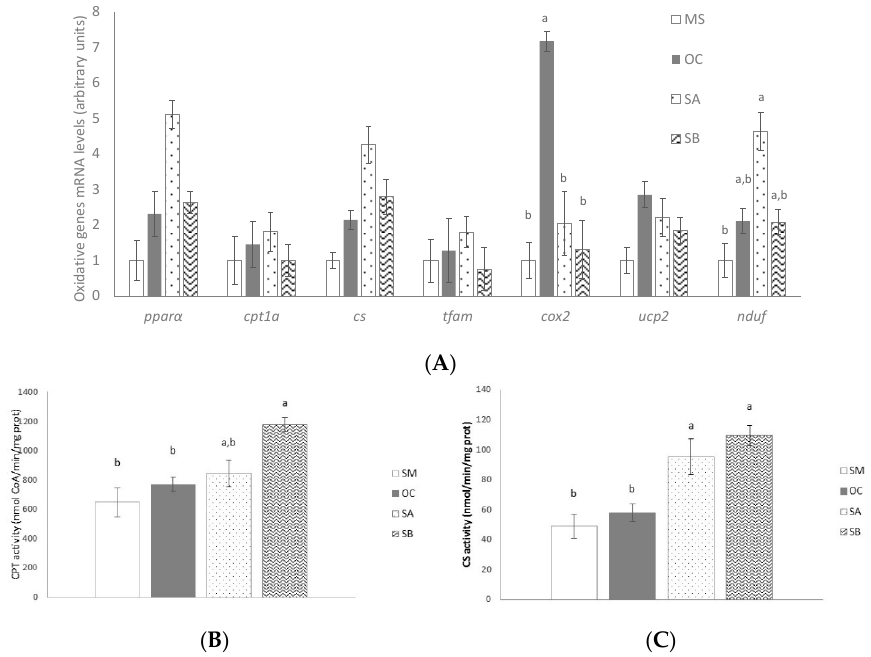
Figure 2. Effects on fatty acid oxidation of MetS rats (MS, n = 10), rats fed with wheat control diet (WC, n = 10), wheat and oat control diet (OC, n = 10), A snack (SA, n = 10), and B snack (SB, n = 10). ( A ) Oxidative genes mRNA levels, ( B ) CPT activity, and ( C ) CS activity. Values are expressed as mean ± SEM. Values not sharing a common letter are significantly different ( p < 0.05). In the case of CPT1a and CS activities, p value for the comparisons SM and SB groups or OC and SB groups is p < 0.001.